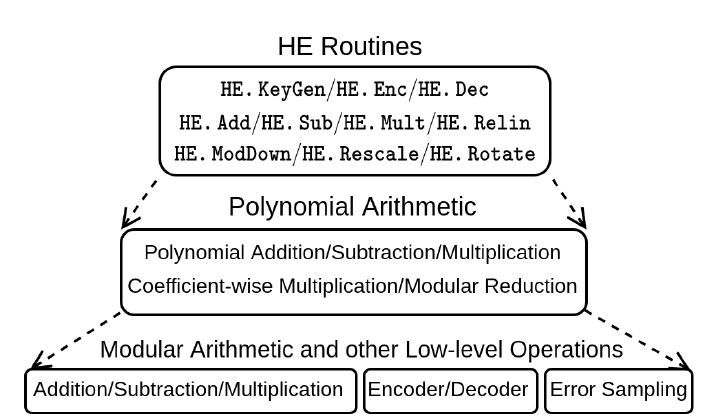
Figure 1: Implementation hierarchy of homomorphic encryption. Key generation, encryp- tion, and decryption are performed on the user side. These user-side operations also include encoding, decoding, and error sampling at the lowest level. Homomorphic evaluations on ciphertexts using homomorphic addition, subtraction, multiplication, relinearization, etc., are performed at the cloud side. Our hardware accelerator is designed for accelerating cloud-side operations which are significantly more expensive than user-side